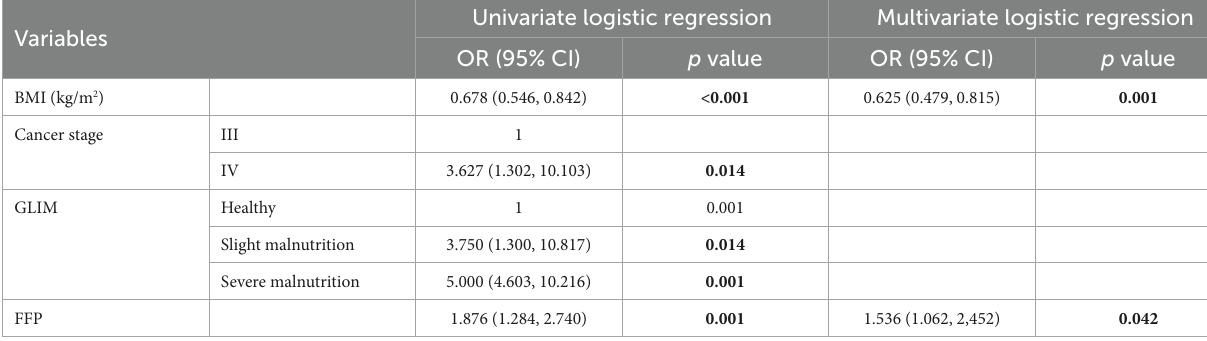
TABLE 5 Univariate and multivariate logistic regression analysis for male.